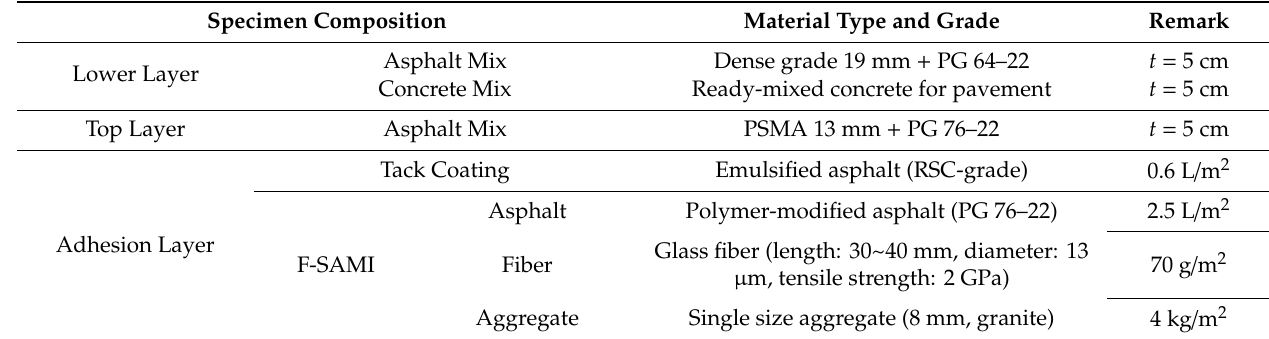
Table 1. Materials and grade for MMLS3 specimen.